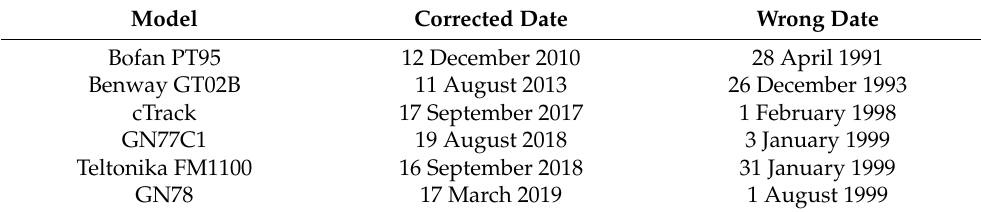
Table 2. Real dataset from different models of GPS units and effects of GPS week number